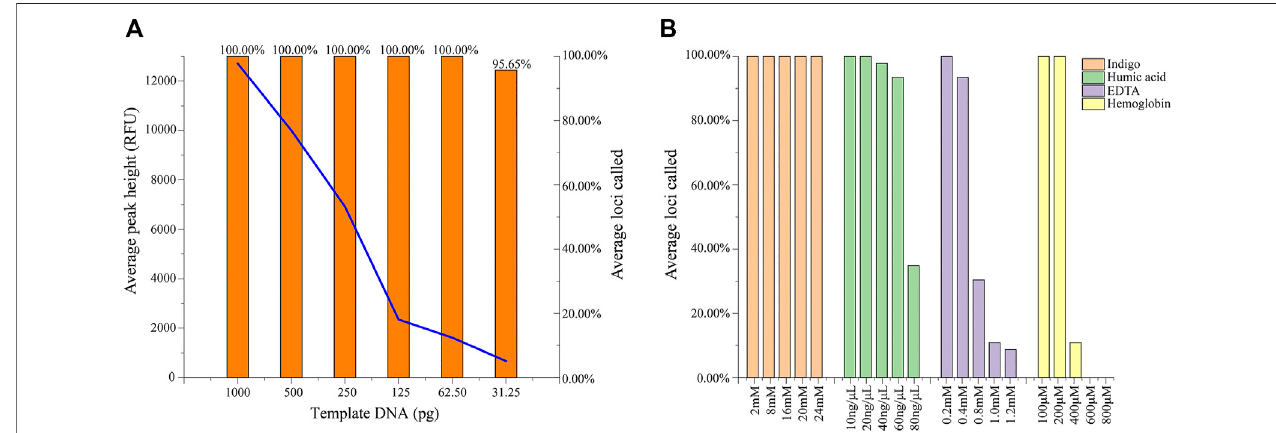
FIGURE 2 | (A) Results of the sensitivity study based on the average peak height and loci called the ratio of control DNA 9948. (B) The average loci called ratio for four common inhibitors of indigo, humic acid, EDTA, and hemoglobin with different concentrations mixed with control DNA 9948.